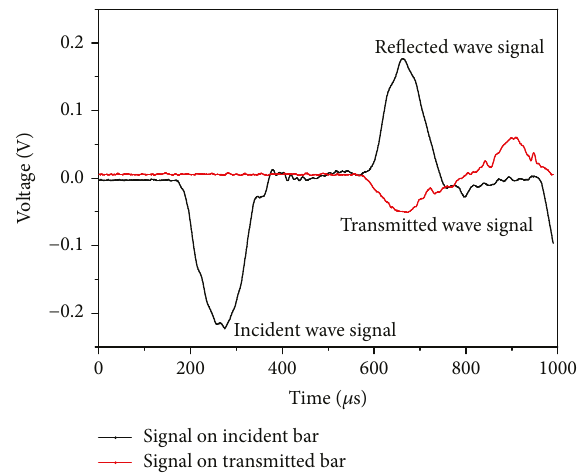
Figure 9: The original signals in a typical SHPB test.